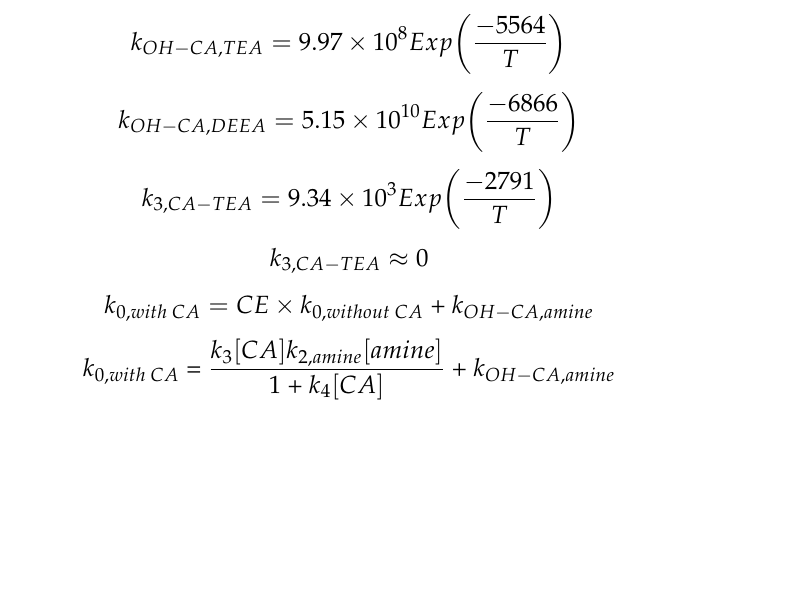
–H O system; ( b ) represents 2 2